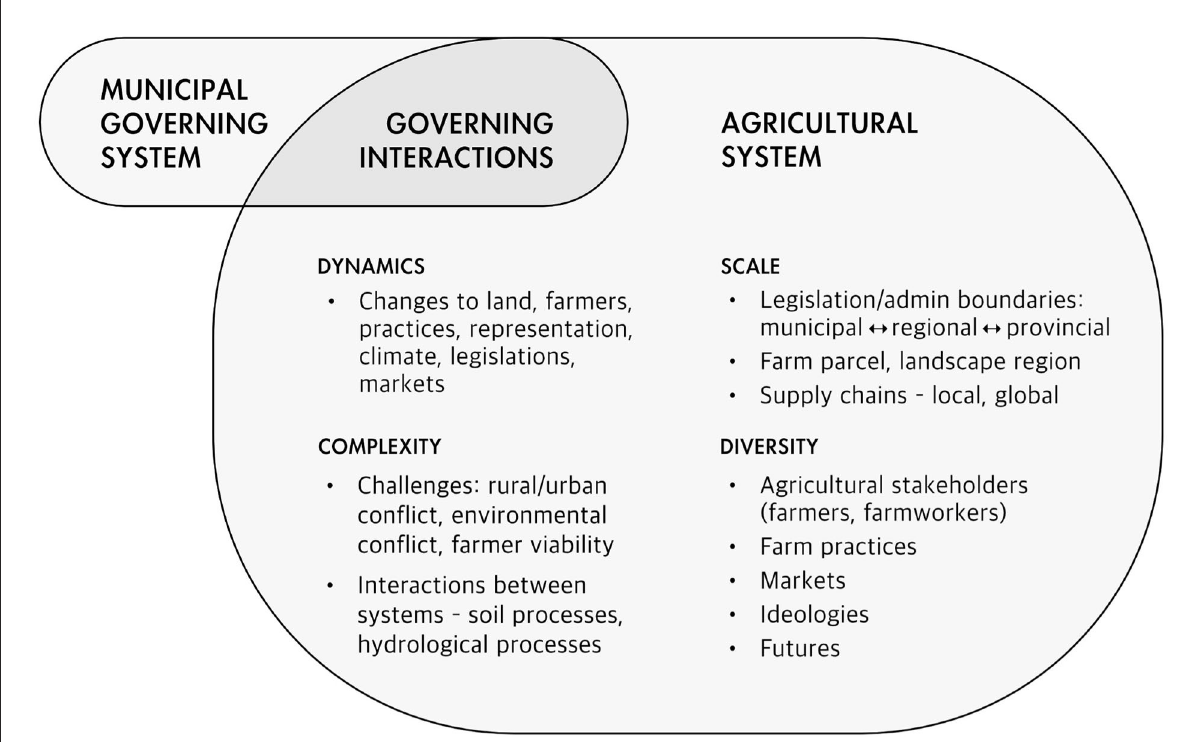
FIGURE3 Governability model (modified from Chuenpagdee and Jentoft,